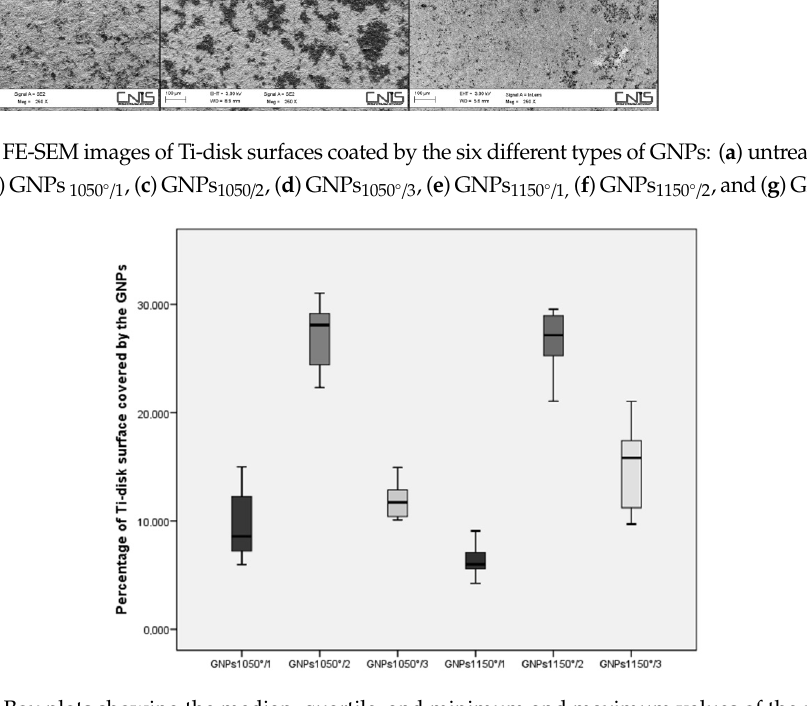
Figure 4. Box plots showing the median, quartile, and minimum and maximum values of the percentage of Ti-disk surfaces coated by the six different types of GNPs. Boxes contain 50% of all values; the horizontal lines inside the boxes indicate the medians, and the vertical lines extend to 1.5 of the interquartile range. Table 3. Differences in the percentage of Ti-disk surfaces covered by the six types of GNPs. Multiple Comparisons